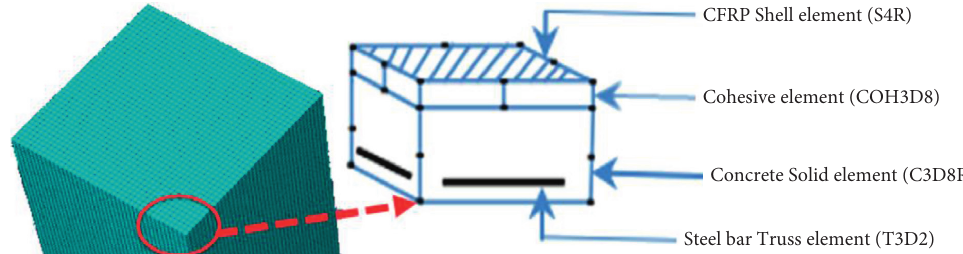
Figure 3: CFRP strengthened RC column model element types.